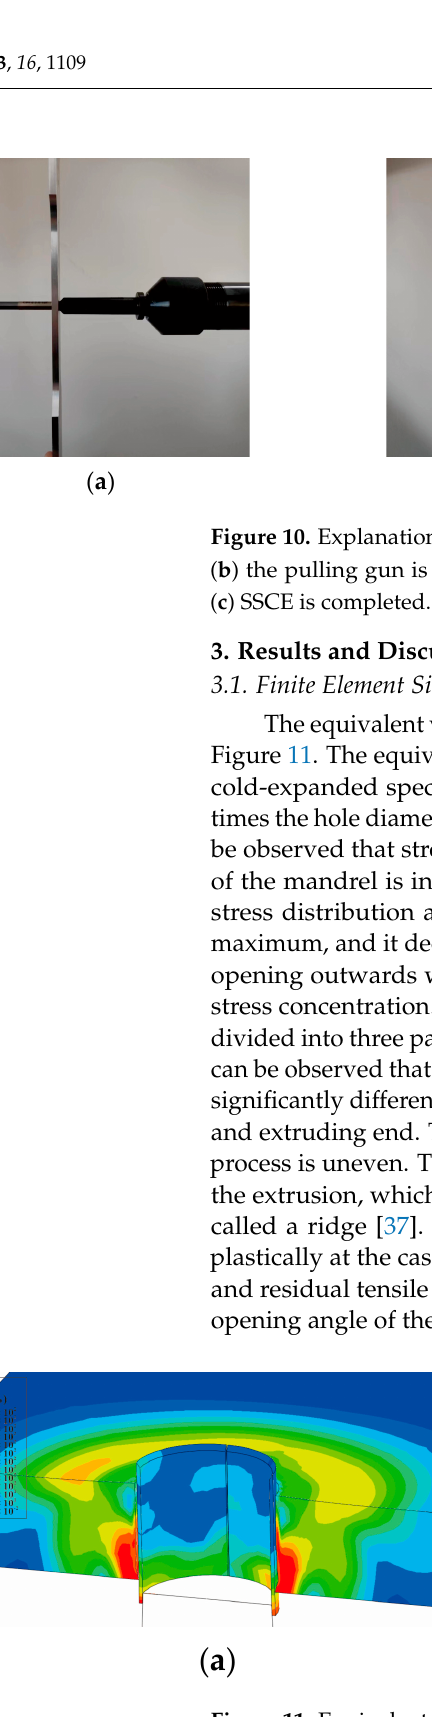
after extrusion of the single hole with concealed split sleeve (the split sleeve is hidden to show clear stress contours).